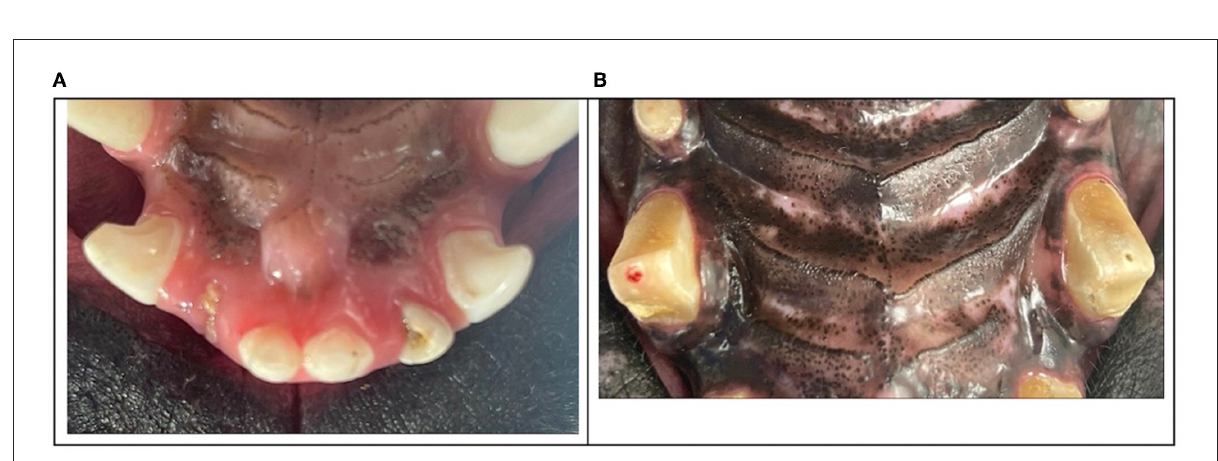
FIGURE5 Clinical photographs of the most injured teeth with enamel-dentin-pulp fractures were the right maxillary second incisor tooth, the left maxillary second incisor tooth (A) , the right maxillary canine tooth, and the left maxillary canine tooth (B) .